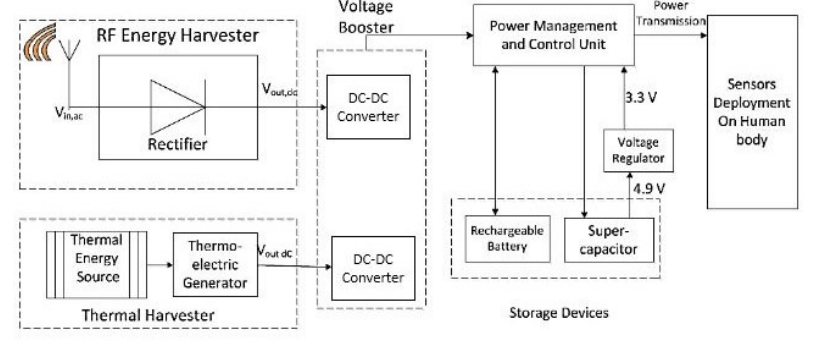
Figure 3. Proposed hybrid energy harvesting receiver